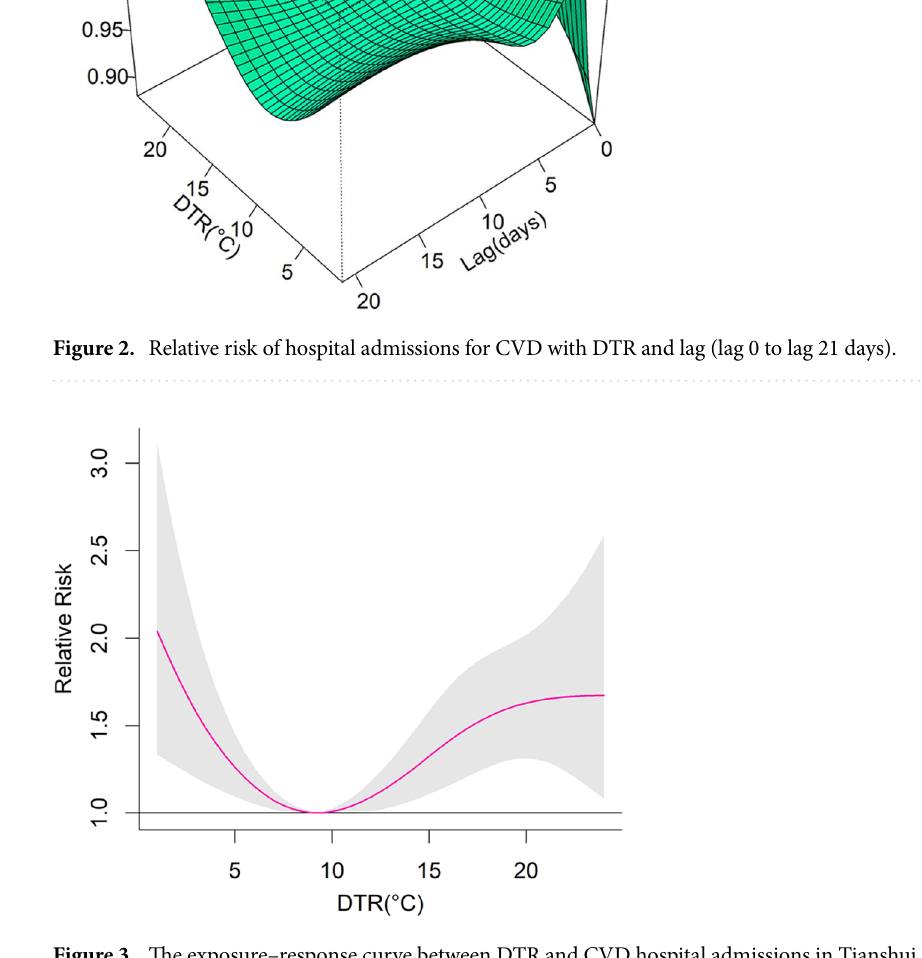
Figure 3. The exposure–response curve between DTR and CVD hospital admissions in Tianshui,